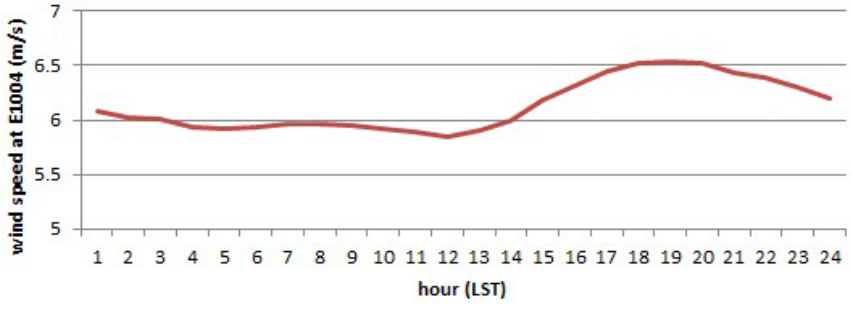
Figure 8. Diurnal variation of wind speed at 20 m observated at